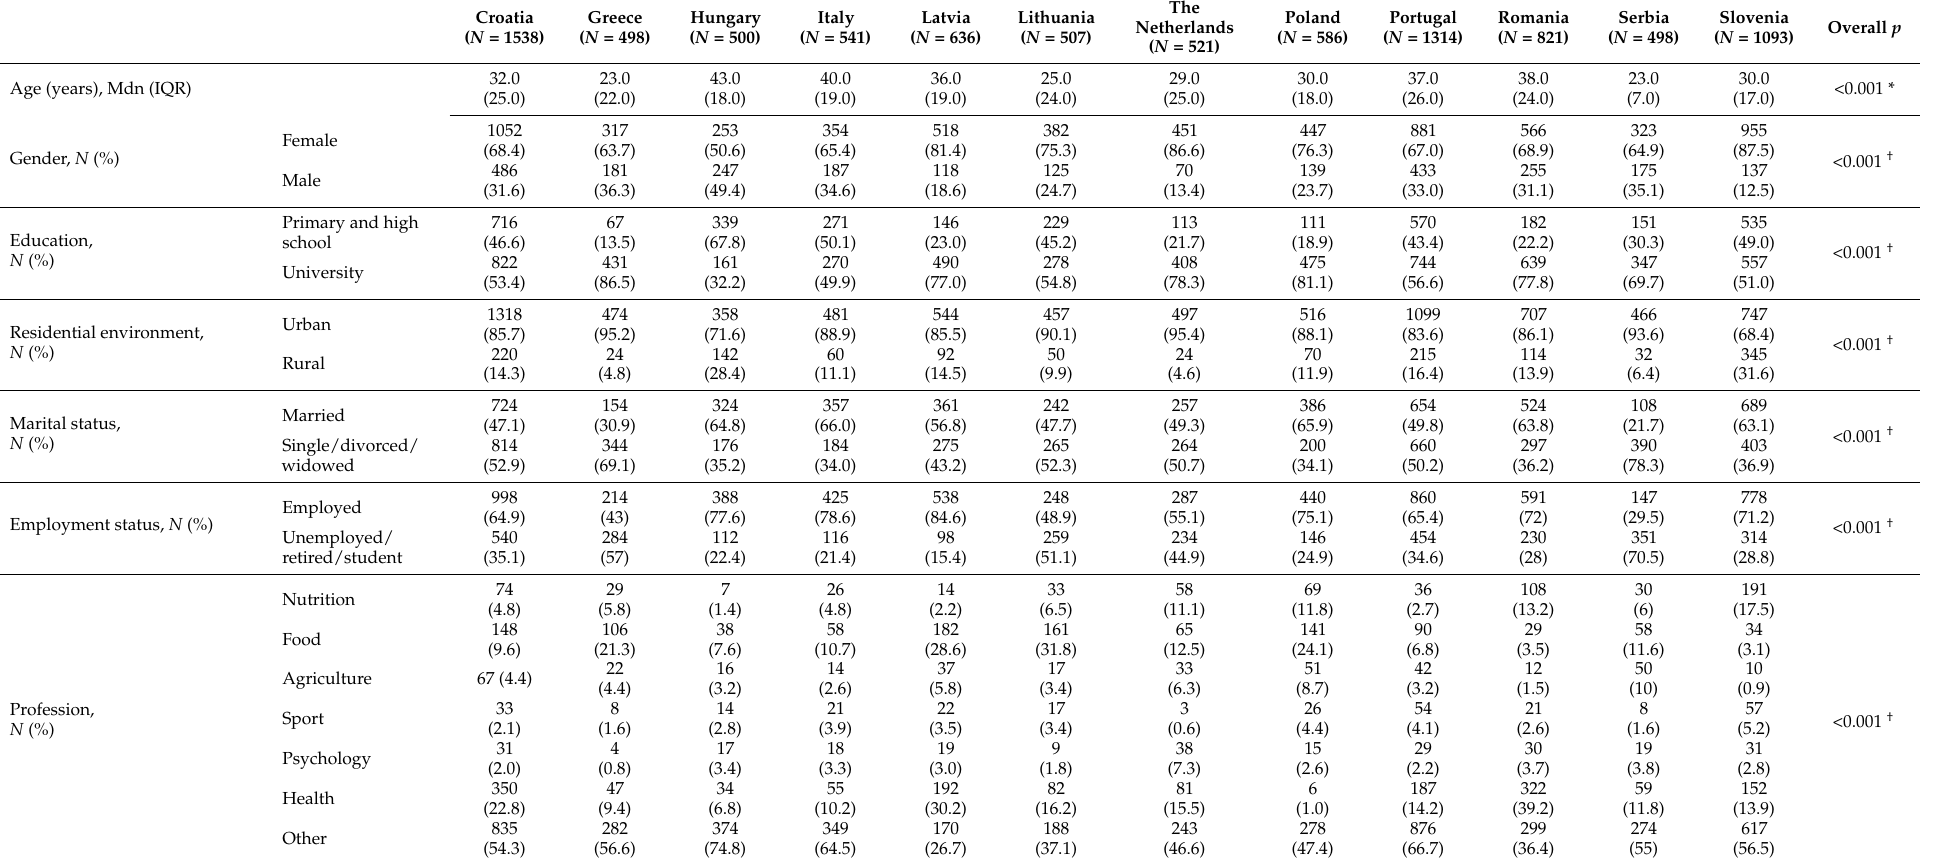
Table 1. Sociodemographic data, lifestyle characteristics, and motivation for health behavior of the study population ( N =